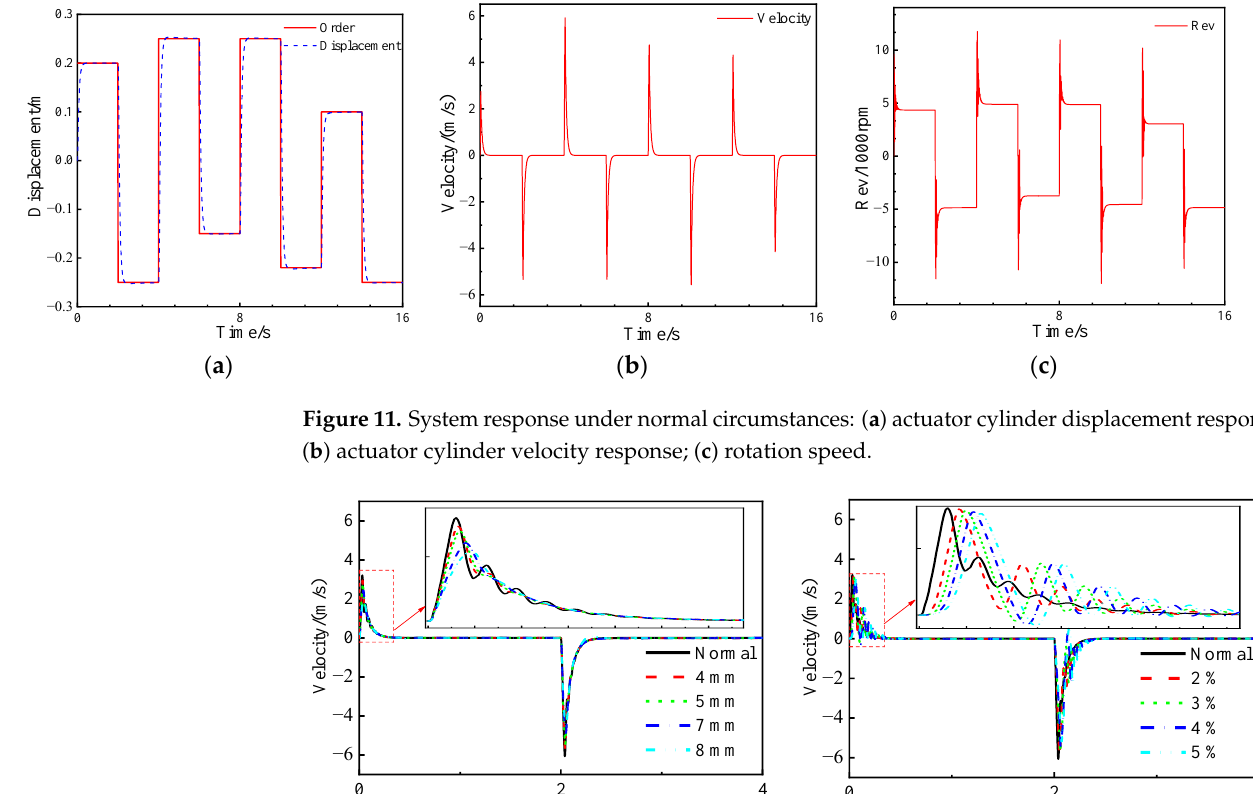
Figure 10. Physical simulation model of EHA-FPVS: ( a ) Model of hydraulic circuit; ( b ) Model of control unit.